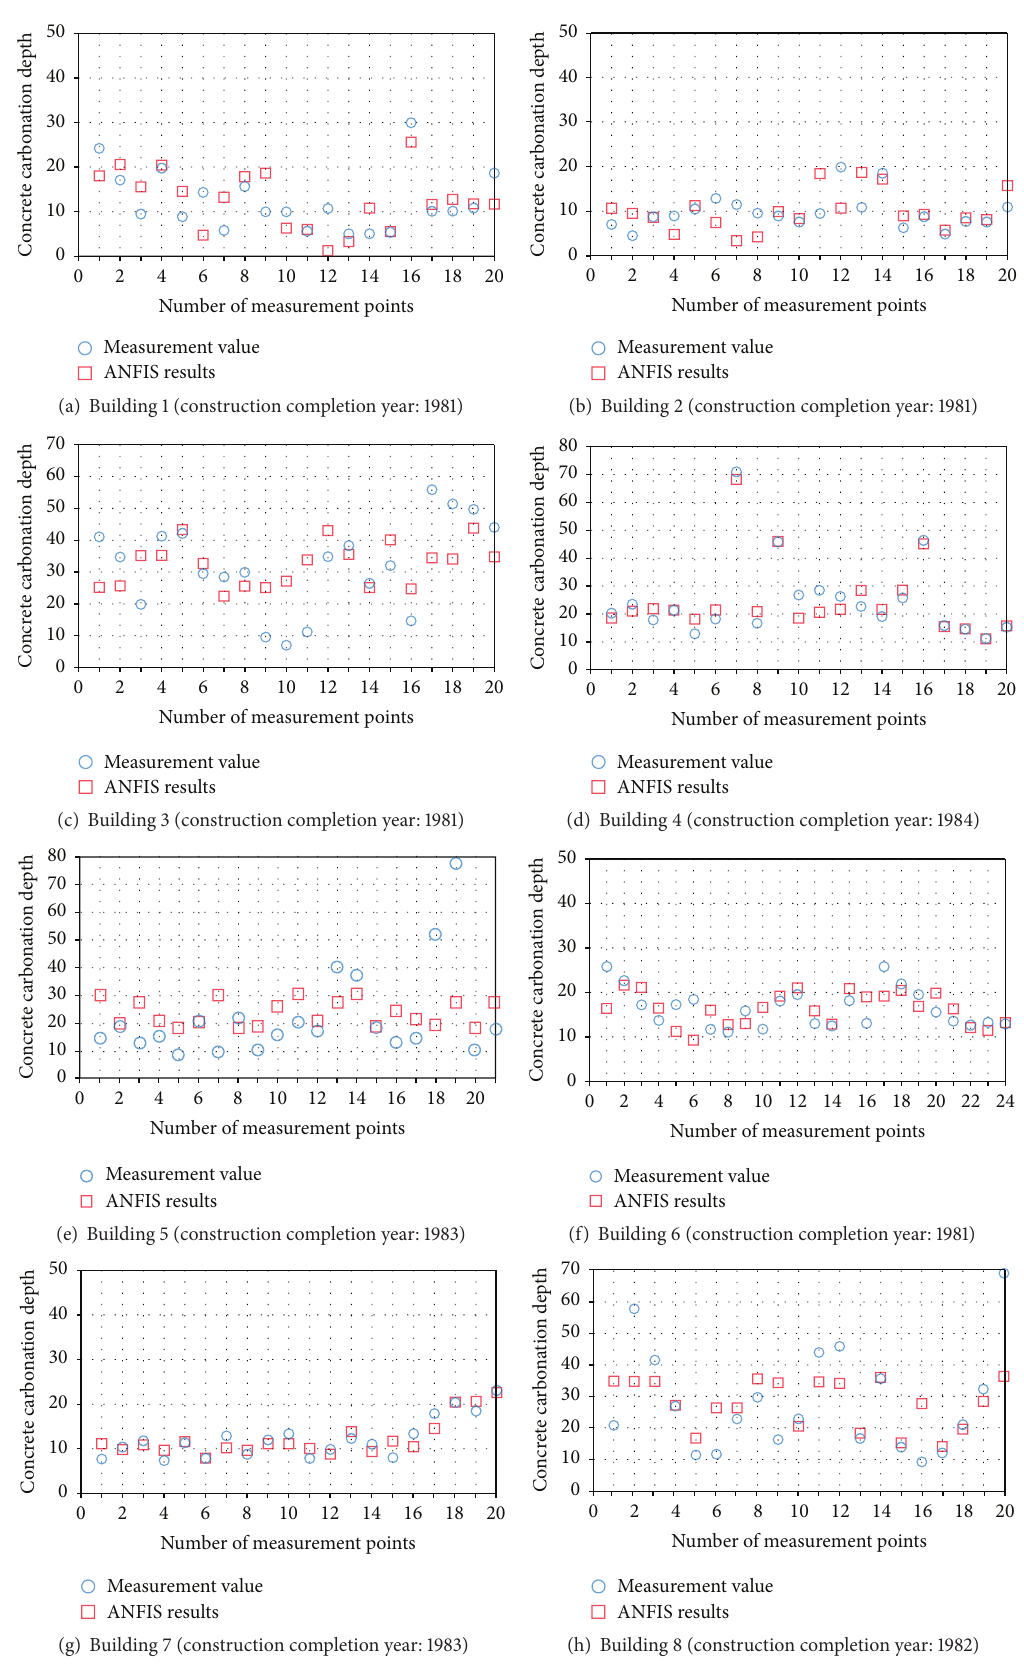
Figure 7: ANFIS results for trained